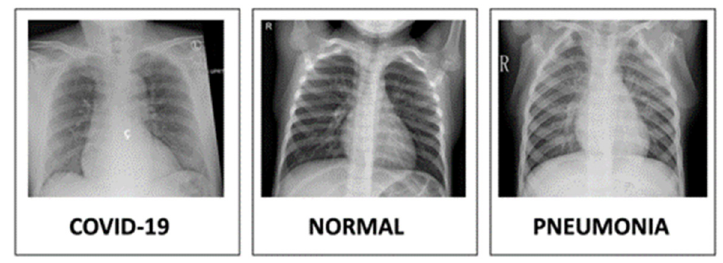
Figure 4. X-ray image examples for healthy and defected lungs [48].